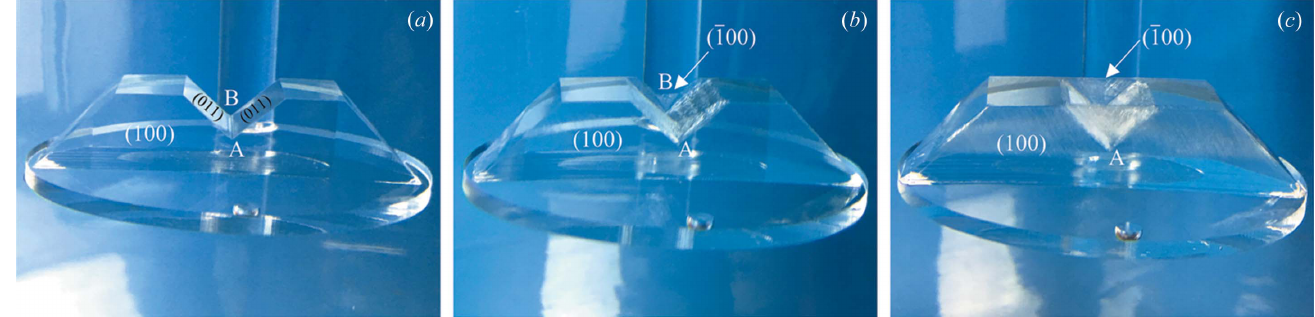
Figure 1 TSLG in the regeneration of a KDP crystal with a concave part. ( a ) Initial incomplete morphology. ( b ) Owing to self-repair, TSLG originates from concave corners A and B. ( c ) Restored (100) and (100) faces with thin surface layers. Figure reproduced from Wang et al. (2019) with permission from Wiley.